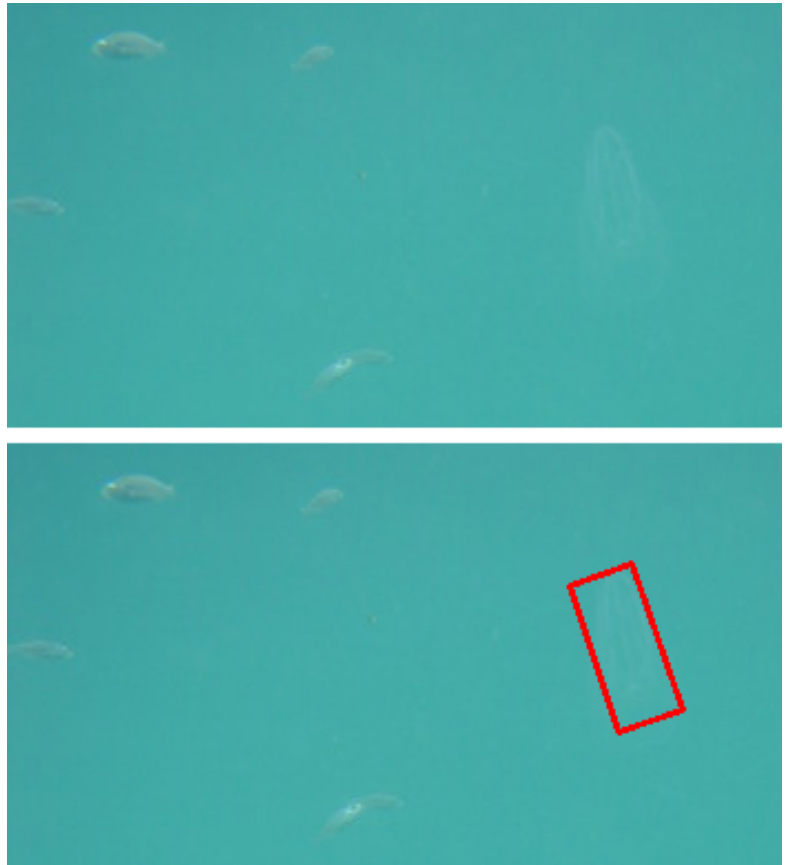
Figure 9. Detail of an image acquired by the GUARD1 system (top panel). A very transparent specimen of Ctenophore is visible on the right side of the panel, close to a small school of fish (on the left side of the panel). In the lower panel the same detail is presented, where the Ctenophore is automatically detected by the recognition algorithm: it is highlighted with the red bounding box and discriminated from the